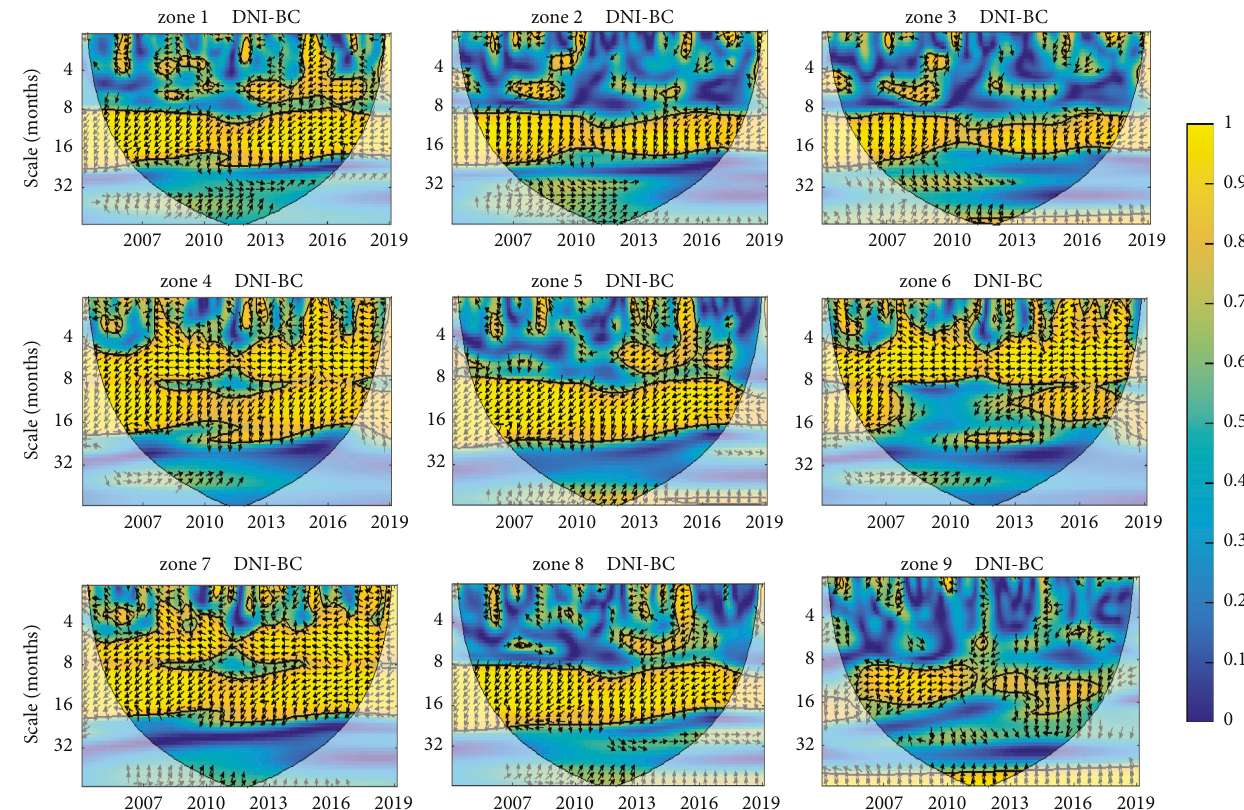
Figure 10: Wavelet coherence between the monthly average of DNI and BC time series (2005–2019). Areas of statistical significance are circled in black; the area outside the cone of influence has no statistical significance. The relative phase dependence is indicated by arrows (antiphase as oriented toward the left, and DNI in advance of phase to BC as arrows pointed